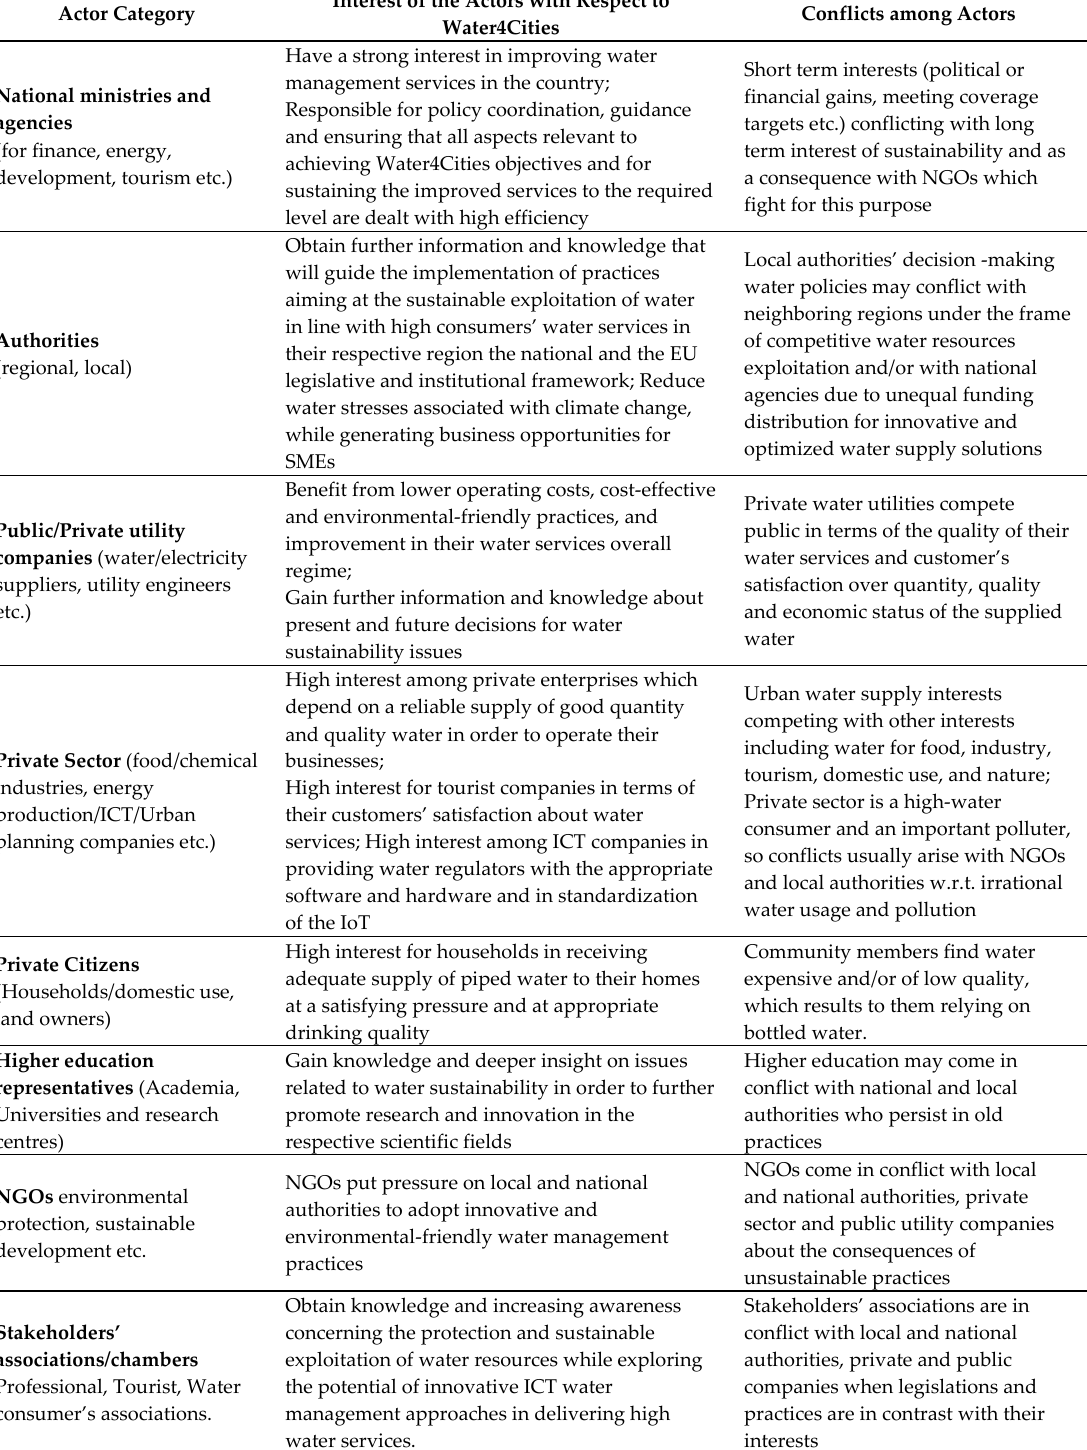
Table 1. Water4Cities Stakeholders: Main Interests and